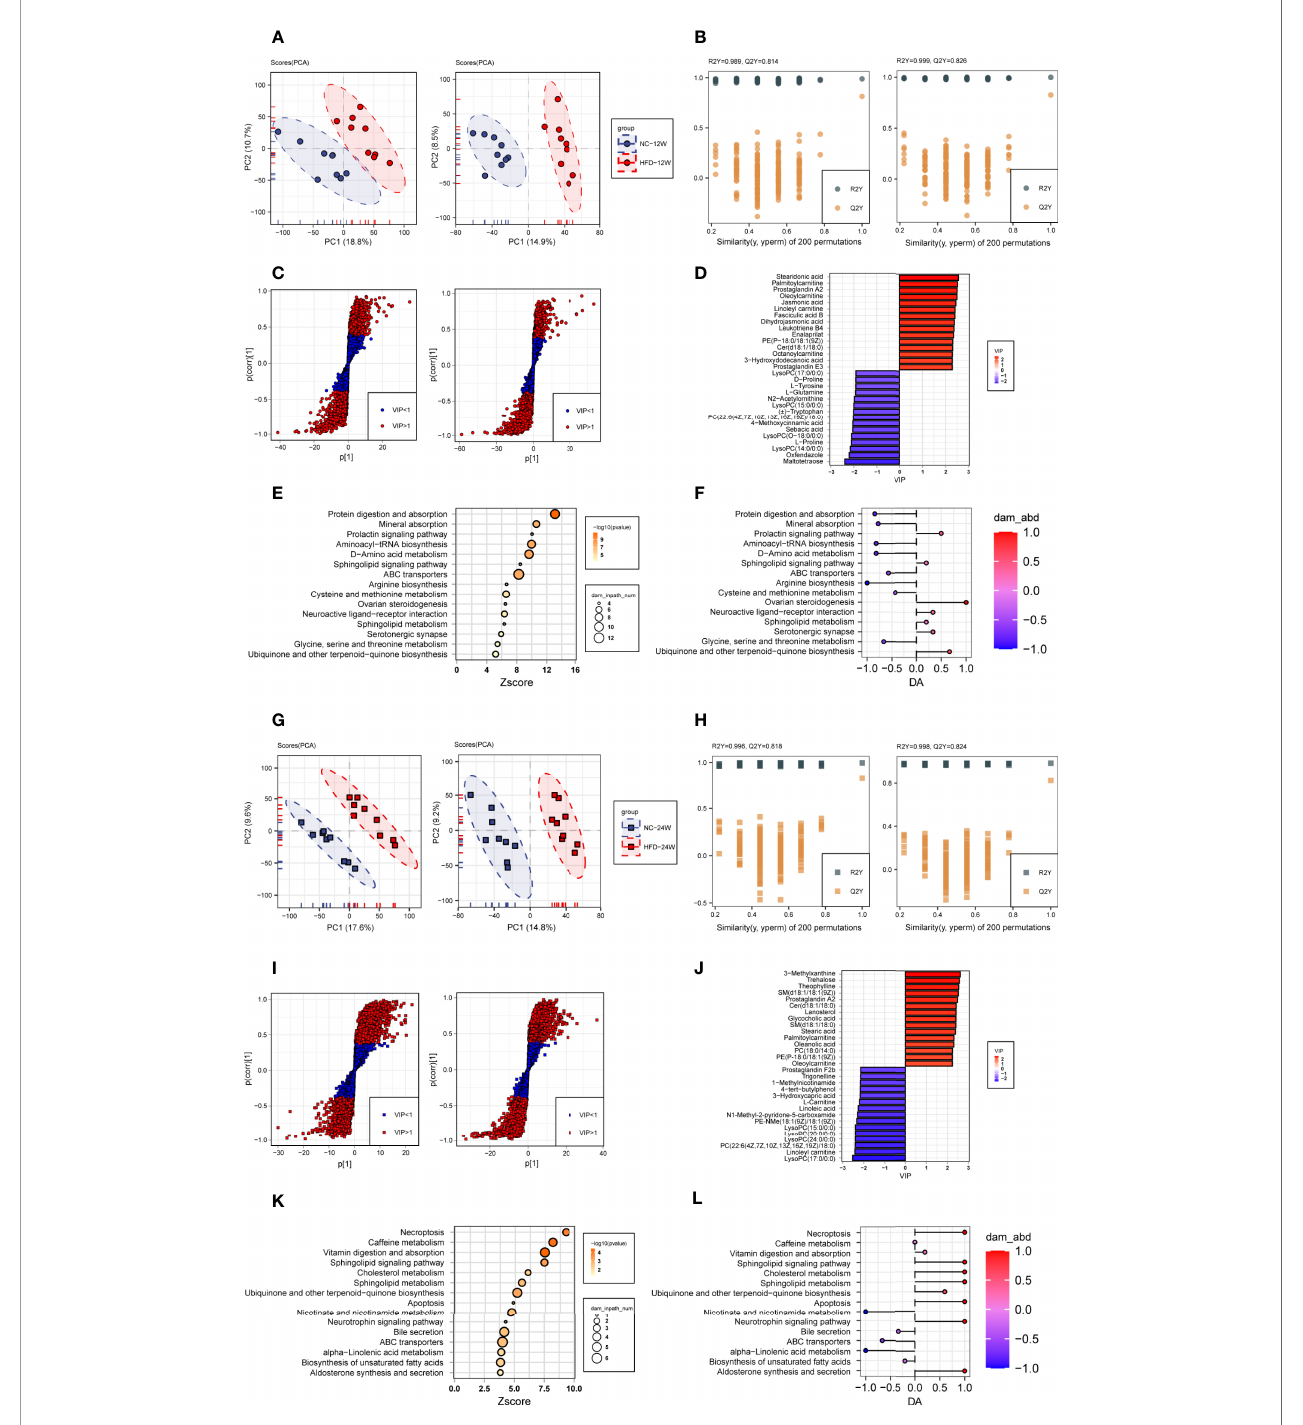
FIGURE 5 | Plasma metabolome changes related to HFD-induced metabolic disorder. (A, B) Principal component analysis ( A , PCA) and orthogonal partial least squares discriminant analysis ( B , OPLS-DA) of canine plasma samples at 12 weeks in positive (left) and negative (right) ion modes. (C) Screening of differential metabolites based on the variable importance for the projection (VIP) in the OPLS-DA model in positive (left) and negative (right) ion modes. Signi fi cant difference was de fi ned as VIP>1 and P <0.05. (D) The endogenous differential metabolites with the highest fold change of expression after merging positive and negative ion patterns. (E, F) Kyoto Encyclopedia of Genes and Genomes (KEGG) pathway enrichment analysis of 153 differential metabolites in 12-week plasma (E) and differential abundance (DA) score of these pathways (F) . (G – L) Metabonomics analysis and metabolite screening of canine plasma samples at 24 weeks corresponding to (A – F)